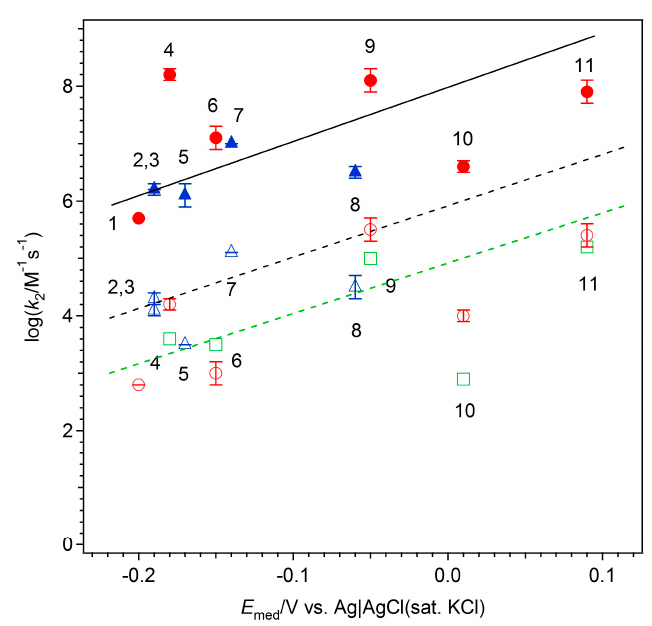
Figure 3. Dependence of the logarithmic bimolecular rate constants for FAD-GDH (closed symbols) and glucose oxidase (open symbols) on the formal potential of the mediators at pH 7.0: MeNQ (1), TB (2), AA (3), PQ (4), MB (5), 14NQ (6), TH (7), MG (8), 12NQ (9), 12NQS (10), and BQ (11). (See Table 1 for the abbreviation definitions.) The error bars were evaluated by a Student’s t -distribution at a 90% confidence level. Phenothiazines are depicted as blue triangles, and quinones are depicted as red circles. The glucose oxidase from the Penicillium vitale –quinone system is shown as green squares [27]. Black solid, black dashed, and green dashed lines represent the regression lines for FAD-GDH from A. terreus and GOx from A. sp. and GOx from P. vitale [27].